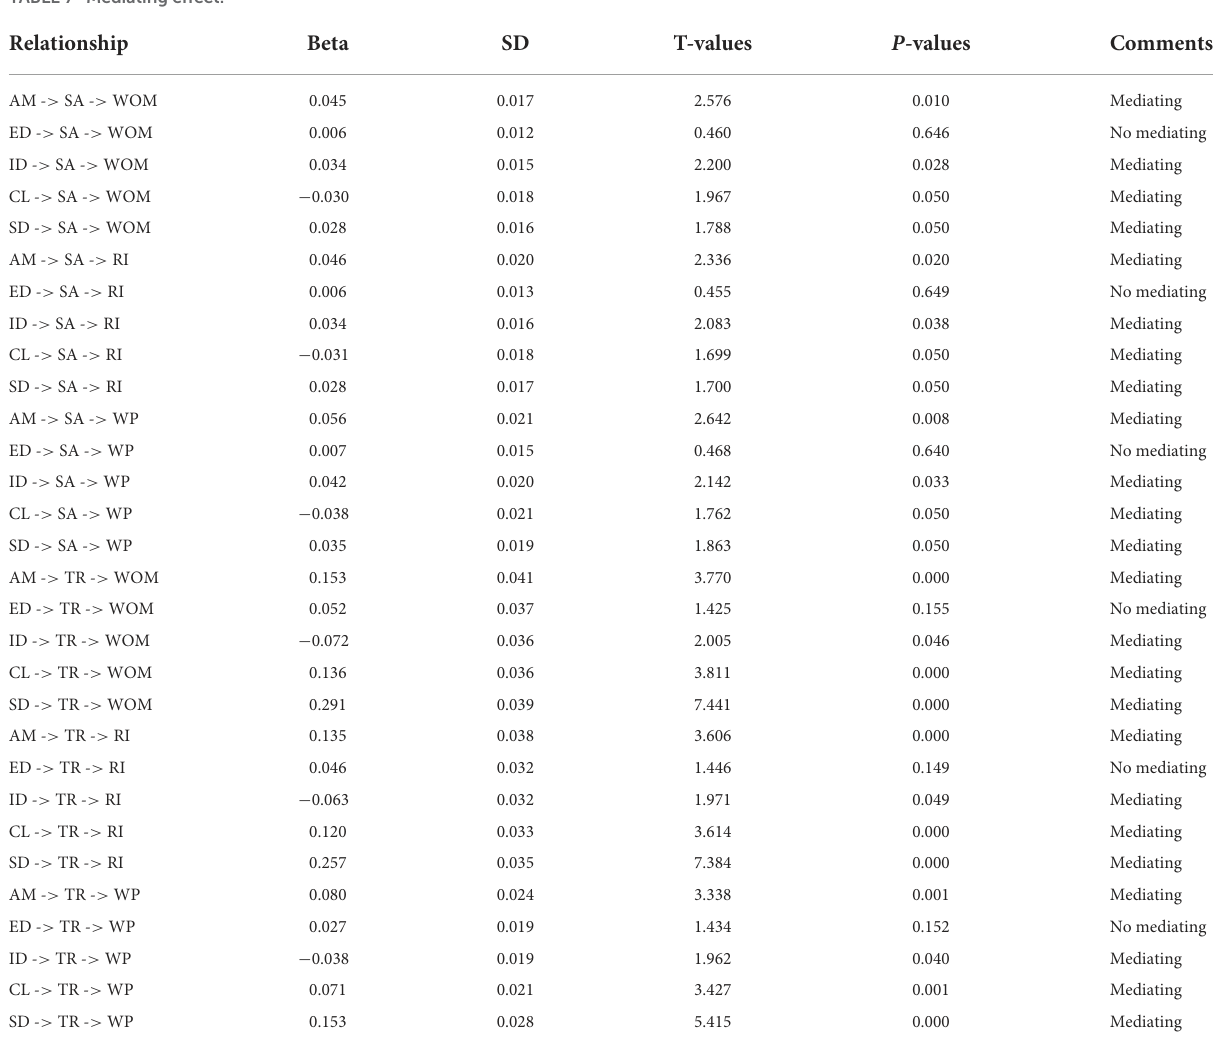
TABLE 7 Mediating